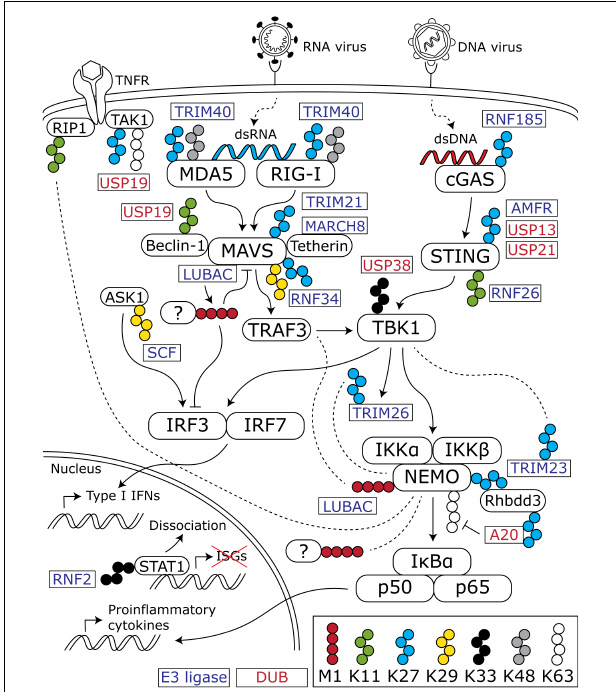
FIGURE 1 | Overview of ubiquitin chains that modulate the antiviral innate immune response. Cytosolic viral nucleic acids are recognized by the dsRNA sensors MDA5 and RIG-I and the dsDNA sensor cGAS. These activate downstream signaling cascades that converge at TBK1 and lead to subsequent activation of the transcription factors IRF3 and -7 and the NF κ B subunits p50 and p65. IRF3 and -7 induce the production of type I IFNs, whereas p50 and p65 stimulate proinflammatory cytokine production. In addition to K48- and K63-linked chains, atypical chains are important regulators of the activation and downregulation of the innate immune response. For the sake of clarity, K48- and K63-linked chains are only depicted when an interaction with one of the atypical chains is shown in the discussed literature. Blocks with rounded corners present key innate immune factors, whereas rectangles represent E3 ligases (blue text) and DUBs (red text) that (de)conjugate the indicated chains. Dashed lines indicate an interaction between the connected protein and ubiquitin